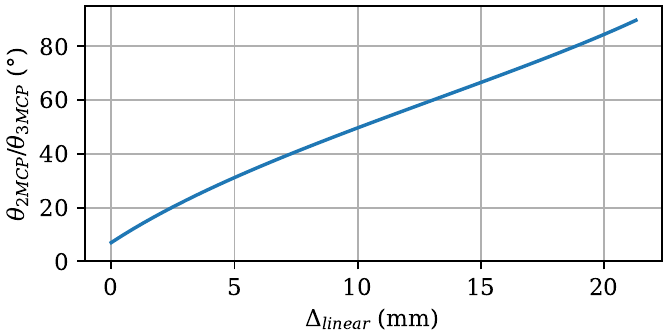
Figure 5. Relation between linear actuator movement and finger flexion in MCP.